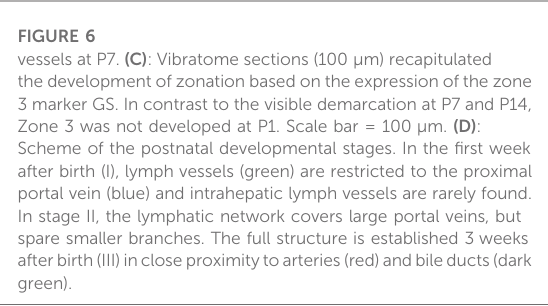
FIGURE 6 vessels at P7. (C) : Vibratome sections (100 µm) recapitulated the development of zonation based on the expression of the zone 3 marker GS. In contrast to the visible demarcation at P7 and P14, Zone 3 was not developed at P1. Scale bar = 100 µm. (D) : Scheme of the postnatal developmental stages. In the fi rst week after birth (I), lymph vessels (green) are restricted to the proximal portal vein (blue) and intrahepatic lymph vessels are rarely found. In stage II, the lymphatic network covers large portal veins, but spare smaller branches. The full structure is established 3 weeks afterbirth(III)incloseproximitytoarteries(red)andbileducts(dark